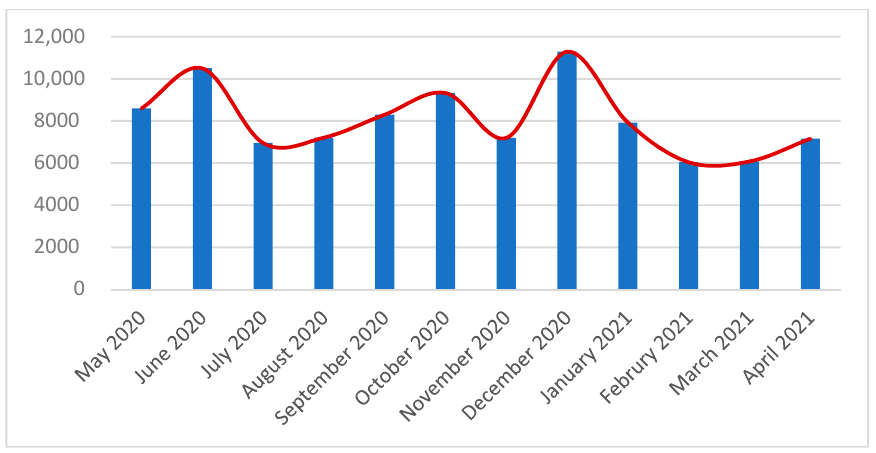
Figure 1. Number of EU users attacked by financial malware from May 2020–April 2021. (source: Kaspersky Security Bulletin 2020–2021. EU statistics|Securelist).